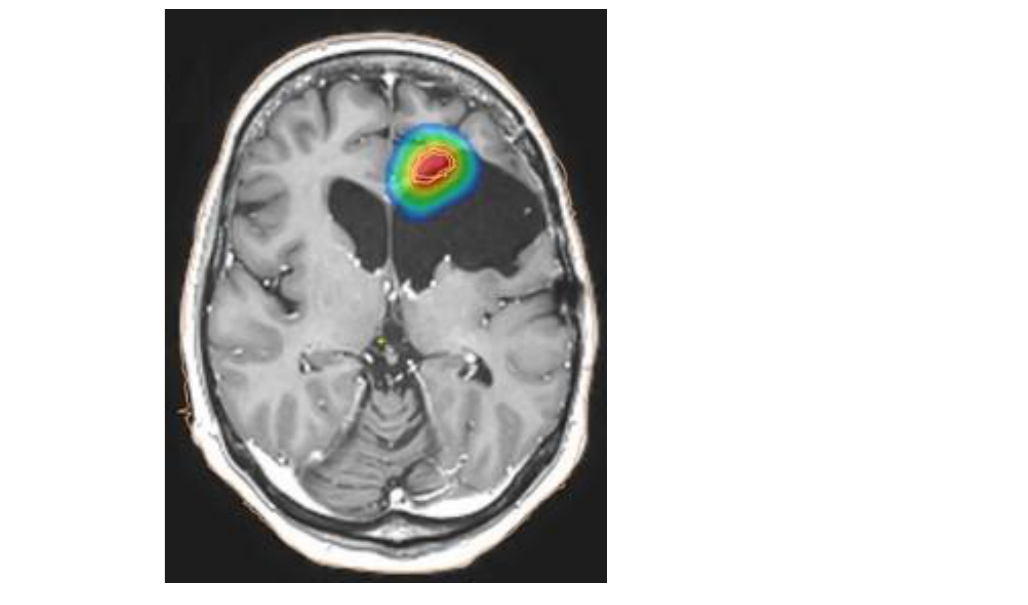
Figure 2. Example of dose distribution for small lesion treated with stereotactic radiotherapy: the colors correspond to an EQD2a/b = 2 of blue >8 Gy; green >30 Gy; yellow >40 Gy; red >50 Gy.